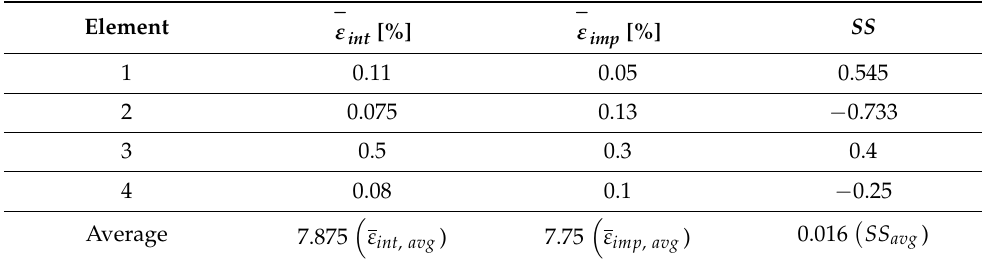
Table 4. Errors caused by average equivalent